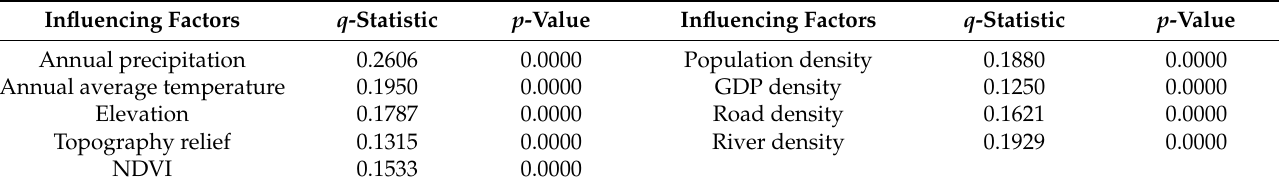
Table 4. The detected results of nine influencing